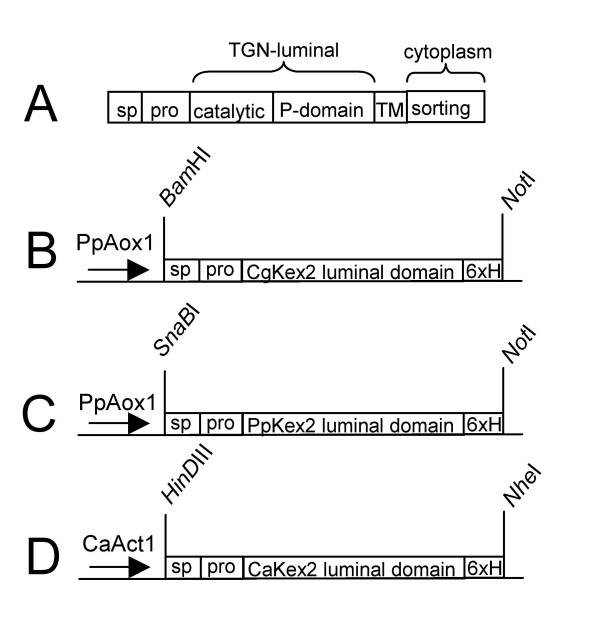
Plasmid constructions for proteinase expression. (A) Schematic representation of the domain structure of fungal Kex2 proteins. Kex2 consists of a signal peptide, an autocatalytically removed pro-peptide, a catalytic domain, a structural P-domain, a transmembrane domain and finally a cytosolic domain containing sorting signals to the Golgi apparatus. (B) For expression of C. glabrata Kex2 the part of the gene fused with a C-terminal 6 × His tag was cloned into pPic3.5 using the BamHI and NotI restriction sites. (C) For expression of P. pastoris Kex2 the part of the gene fused with a C-terminal 6 × His tag was cloned into pPic3.5 using the SnaBI and NotI restriction sites. (D) For expression of C. albicans Kex2 the part of the gene fused with a C-terminal 6 × His tag was cloned into pCIp10 using the HinDIII and NheI restriction sites.